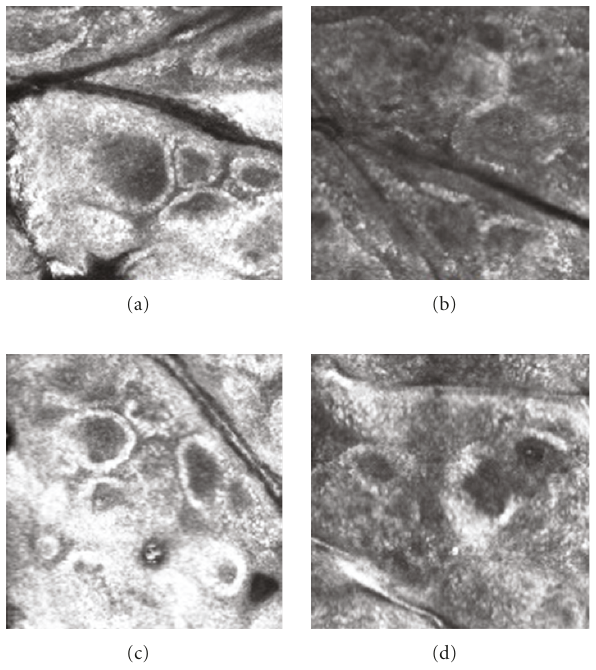
Figure 1: Laser scanning confocal microscopy (LSCM) of supranu- clear melanin caps of dermal-epidermal junction in the forearm skin in relation to UVB exposure. (a) and (b) One representative case before and after (24 hours) 100mj UVB irradiation. (c) and (d) The same case before and after (24 hours) 200 mj UVB